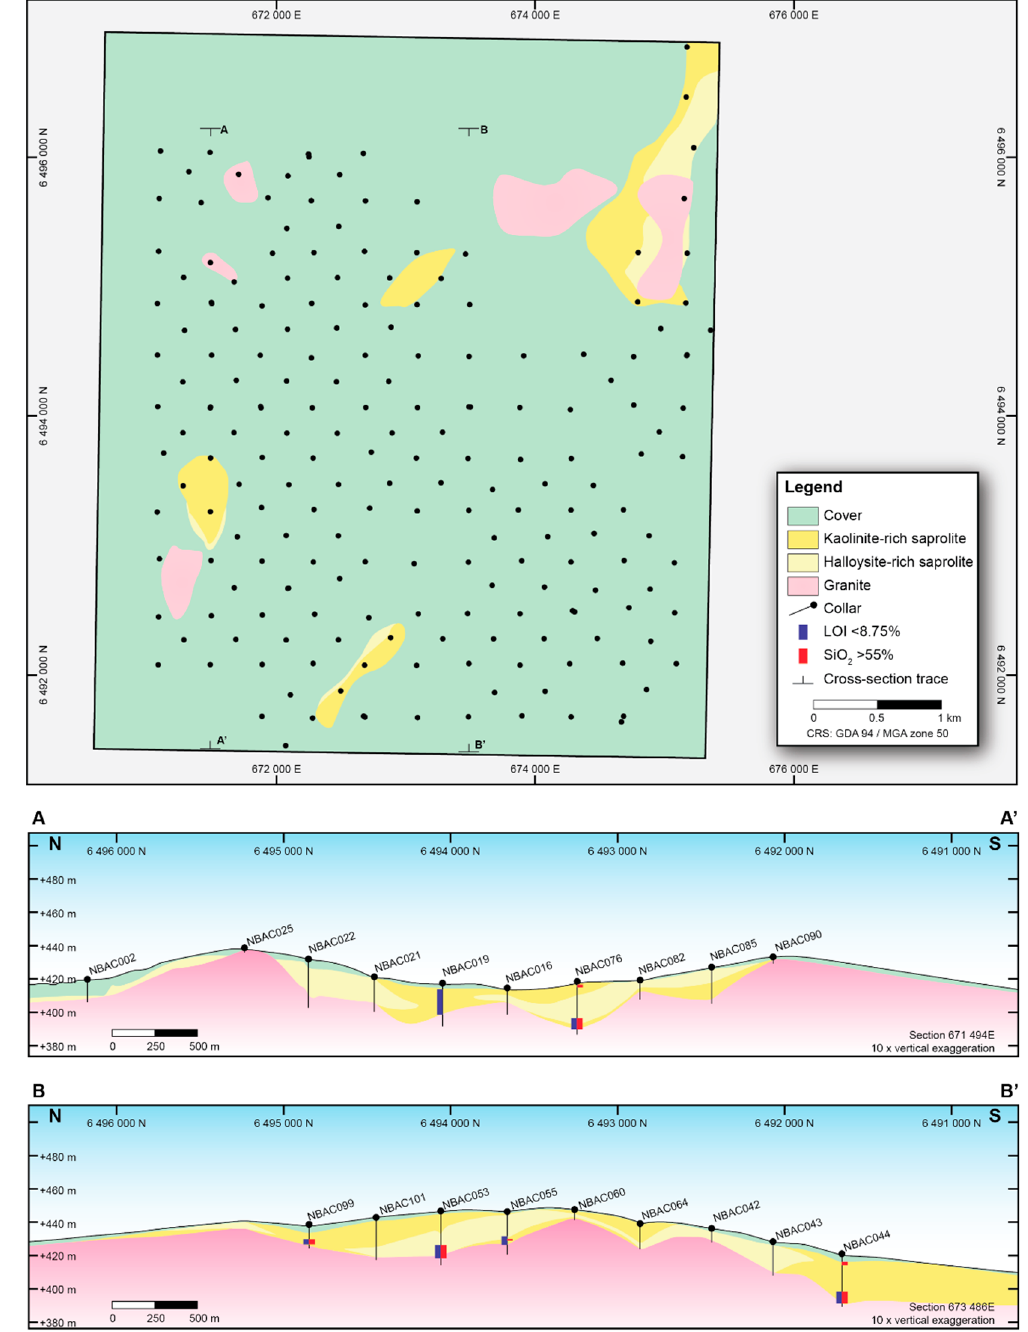
Figure 2. Overview of the surface, drill holes, and undulating fresh granite contact; ( A ) cross-section along 671 494E ( B ) cross-section along 673 486 E.